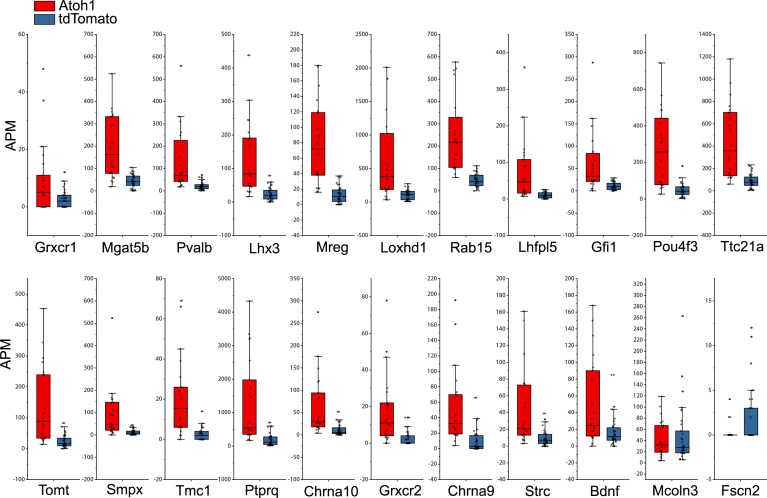
Ad-Atoh1 infected cells showed increased transcripts for many but not all verified hair cell genes.Box-plot for verified hair cell specific genes among top 500 uHC enriched genes. APM: amplicon per million amplicons.